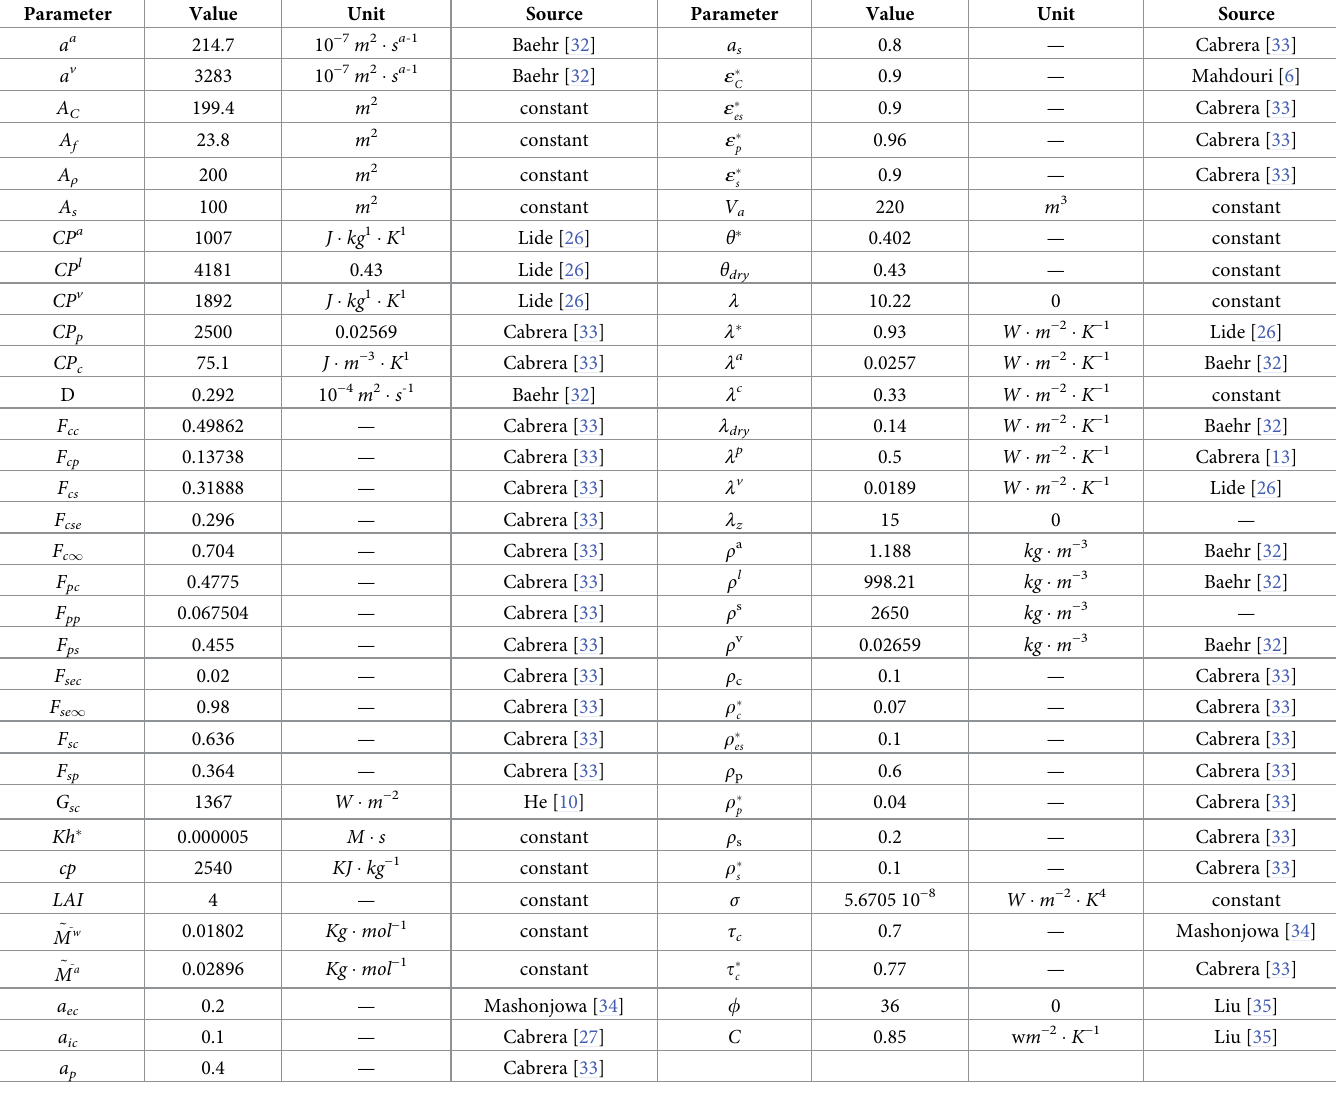
Table 1. Parameters used for the